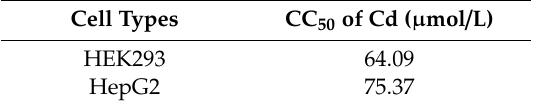
Table 2. Cytotoxicity concentration at 50% (CC 50 ) of CdCl 2 from cells viability determined by MTT